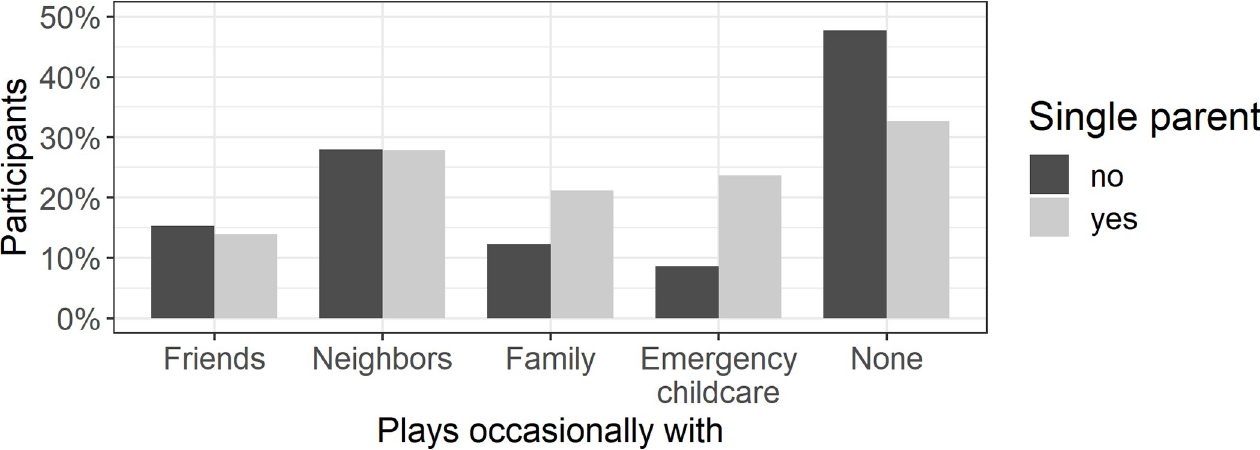
Fig 4. Percentage of parents reporting that their child plays occasionally with friends, neighbors, family members who lived in a different household, that their child occasionally visits the emergency childcare, or that nothing of the aforementioned applies. The percentages are split for single parents and non-single